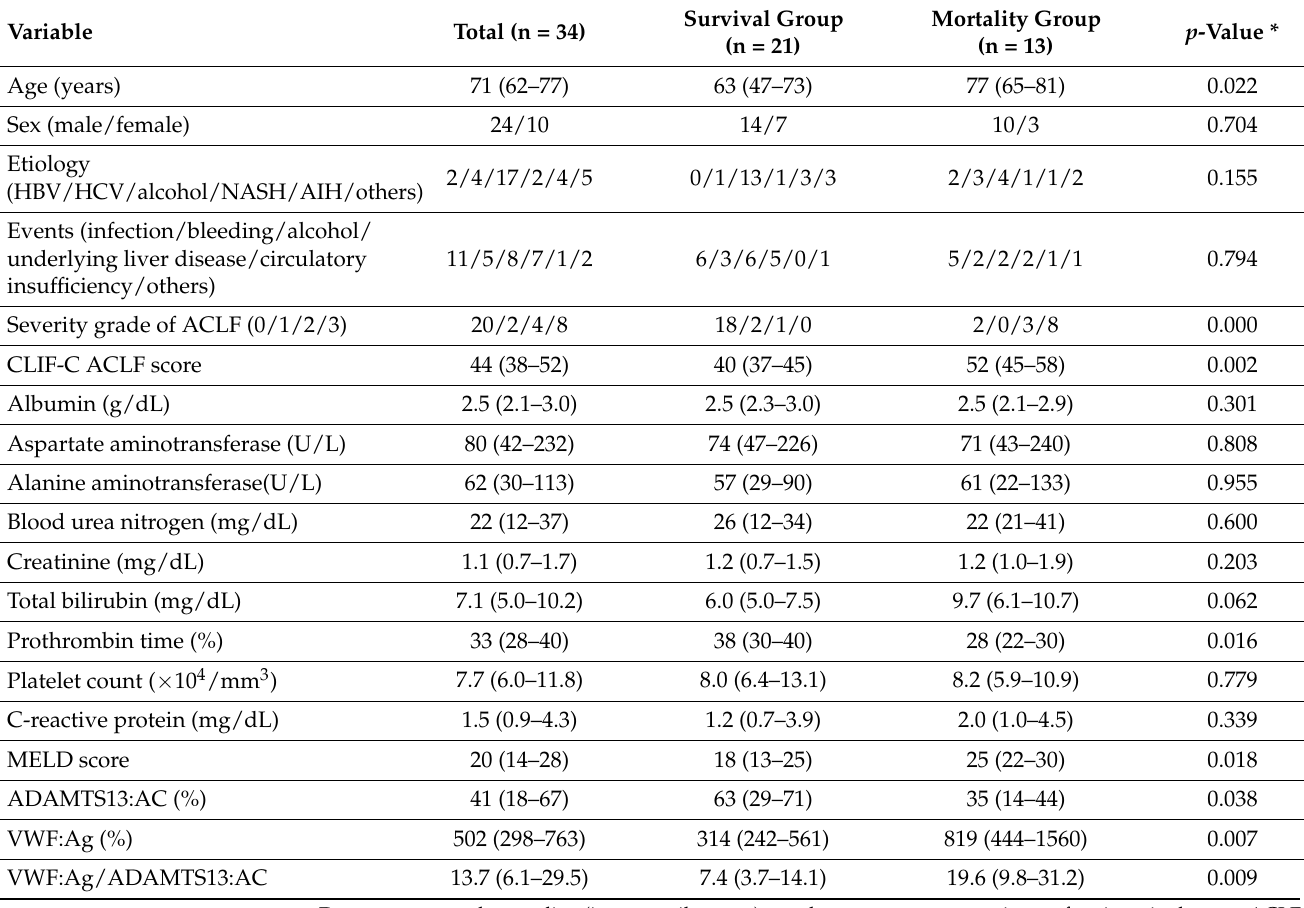
Table 2. Characteristics of patients in the post-ACLF group.